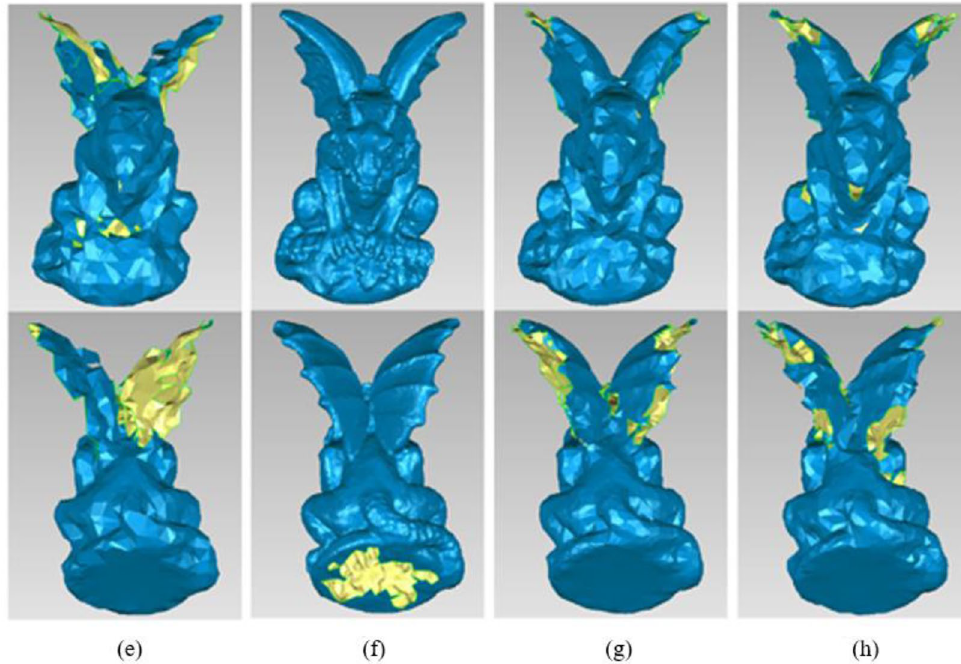
Figure 15. The other reconstruction results of Gargo50k with different simplified methods. ( e ) The simplified method based on octree coding. ( f ) The k-means clustering simplification method. ( g ) The uniform simplification method. ( h ) The geometric algebra